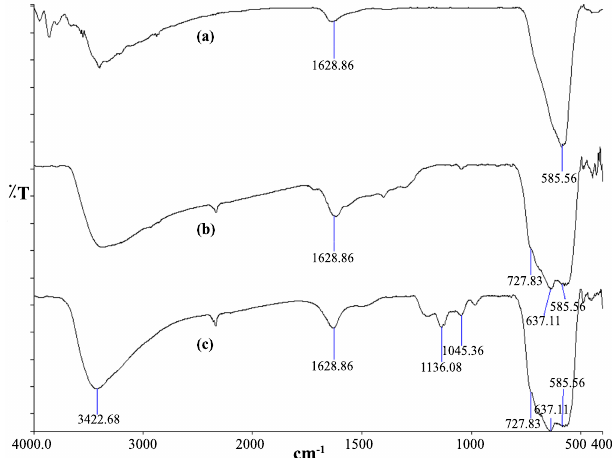
Fig. 1. The comparative FT-IR spectra of (a) nano Fe 3 O 4 ; (b) Fe 3 O 4 @ ZrO 2 ; (c) Fe 3 O 4 @ZrO 2 -SO 3